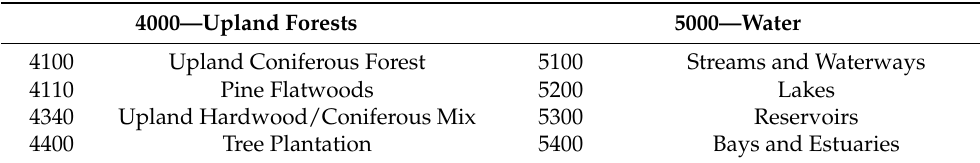
Table 2. Initial SWFWMD Level II FLUCCS sub-classes for the “Upland Forests” and “Water” Level I classes.